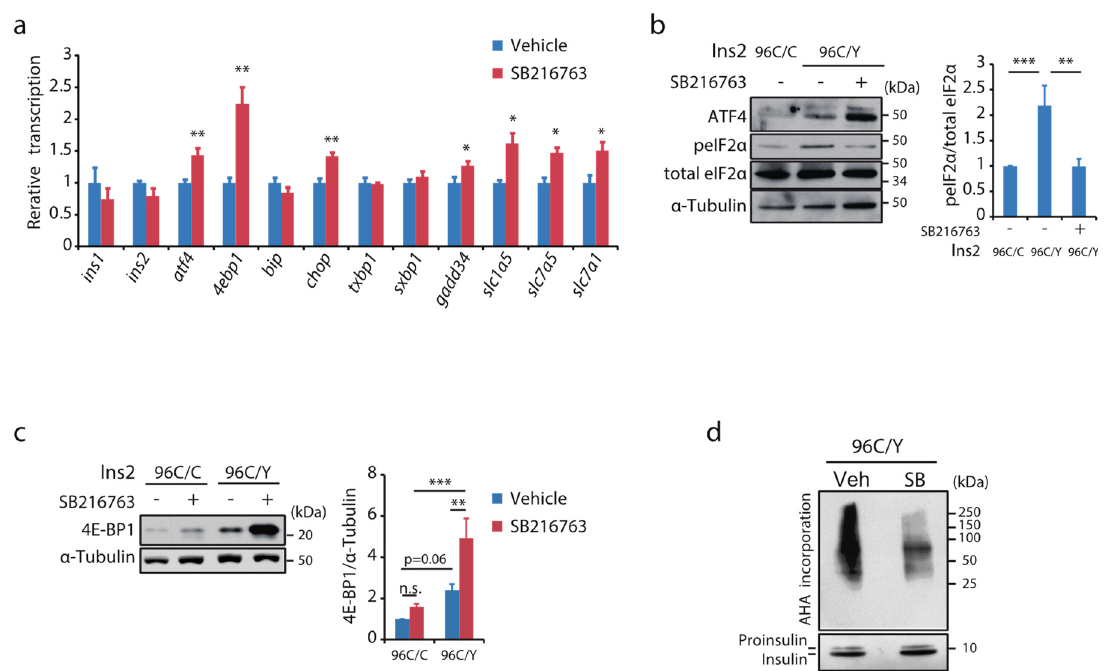
Figure 6. Gsk-3 inhibition modulates ISR in insulinoma cells carrying Ins2 mutation. ( a ) mRNA levels of indicated genes in the mouse insulinoma cells harbouring Ins2 96C/Y were assessed after a 16 h incubation with either GSK-3 inhibitor or vehicle (DMSO) (n = 3). The relative transcription levels were summarised as mean ± SD. * p < 0.05, ** p < 0.01 by unpaired Student’s t -test. ( b , c ) The protein extracts from cells with Ins2 96C/C or those with Ins2 96C/Y incubated with either Gsk-3 inhibitor or vehicle for 16 h were analysed by Western blotting using the indicated antibodies. Relative abundance of ( b ) peIF2 α and ( c ) 4E-BP1 are summarised in the graph (n = 3, respectively). ** p < 0.01, *** p < 0.001 by one-way ANOVA followed by Bonferroni’s post hoc test. ( d ) Metabolic labelling analysis of cells with Ins2 96C/Y and those with Ins2 96C/C incubated with either vehicle or SB216763 for 20 h. The biotin-labelled proteins were collected using the streptavidin beads. The captured extracts were analysed by Western blotting using anti-biotin or anti-insulin